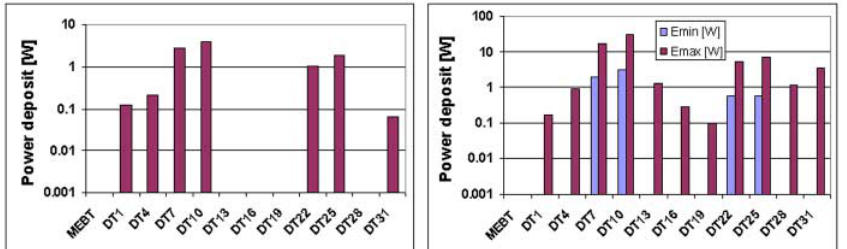
FIG. 17. (Color) Expected power deposited in 8 mm radius DTL collimators. The left-hand plot assumes no errors. The right-hand plot summarizes the results of 100 linac runs with errors. The bore radius of drift tubes is 12.5 mm.